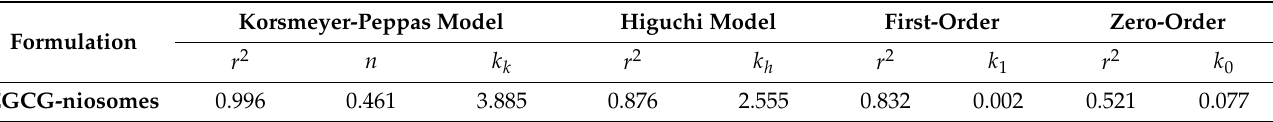
492 Figure 5. The amount of drug deposited in the human skin layers from EGCG-niosomes and EGCG- 493 solution (mean ± SD, n = 3).